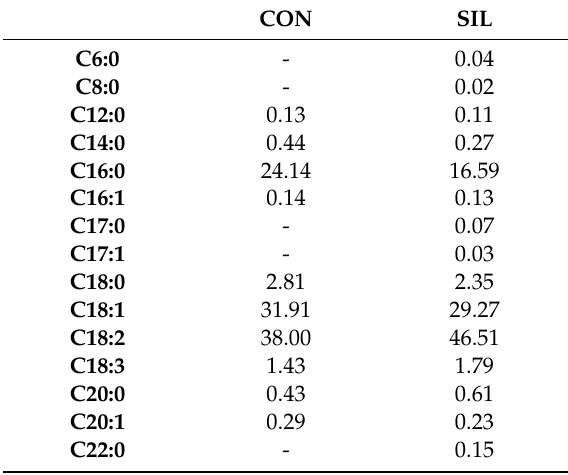
Table 1. Fatty acids (g / 100 g of total fat) of the diets (CON: concentrate; SIL: 70% maize silage + 30%